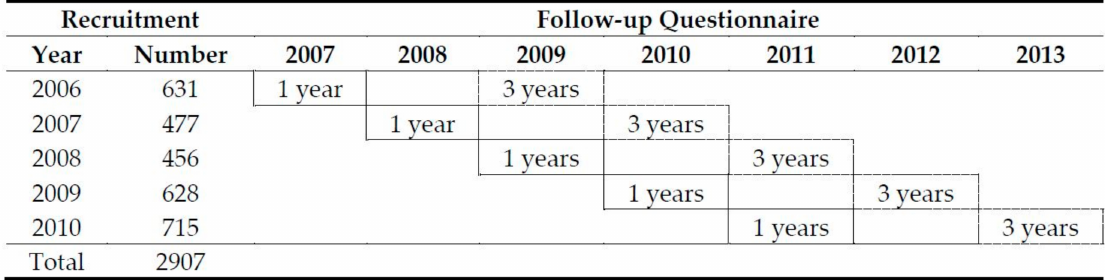
Figure 1. Study cohort, wave 1 (solid border) and wave 2 (dash